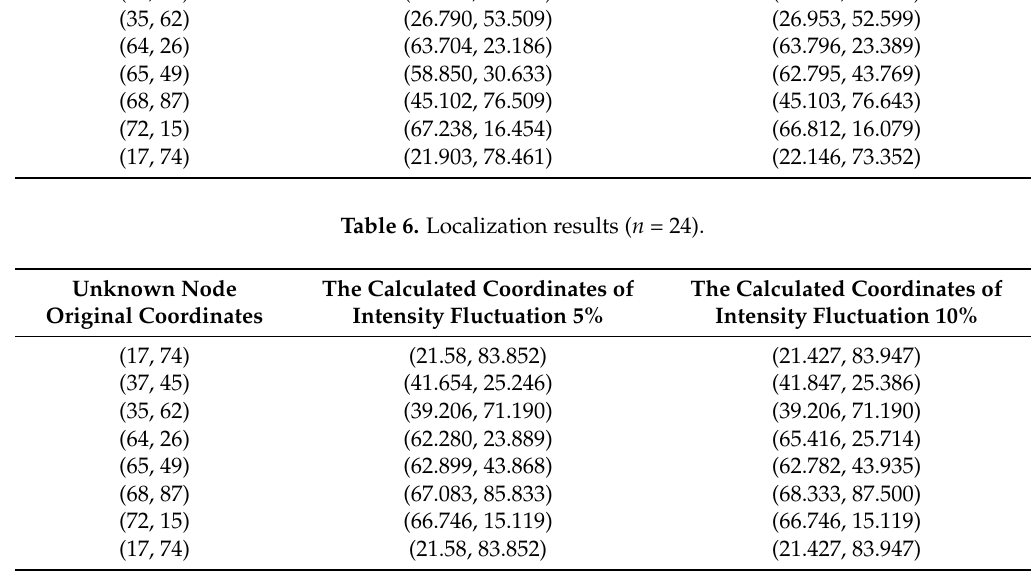
Figure 19. One of the simulation location area distribution maps.